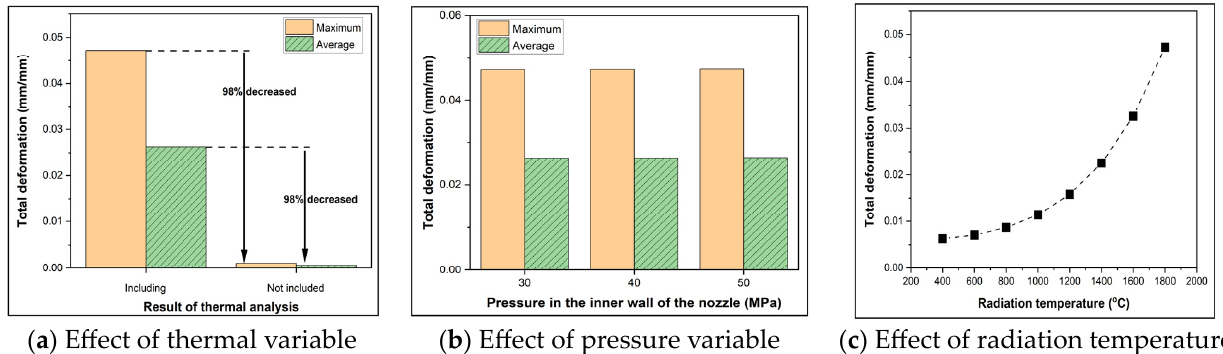
Figure 11. Total deformation results on structure analysis according to temperature and pressure variables.